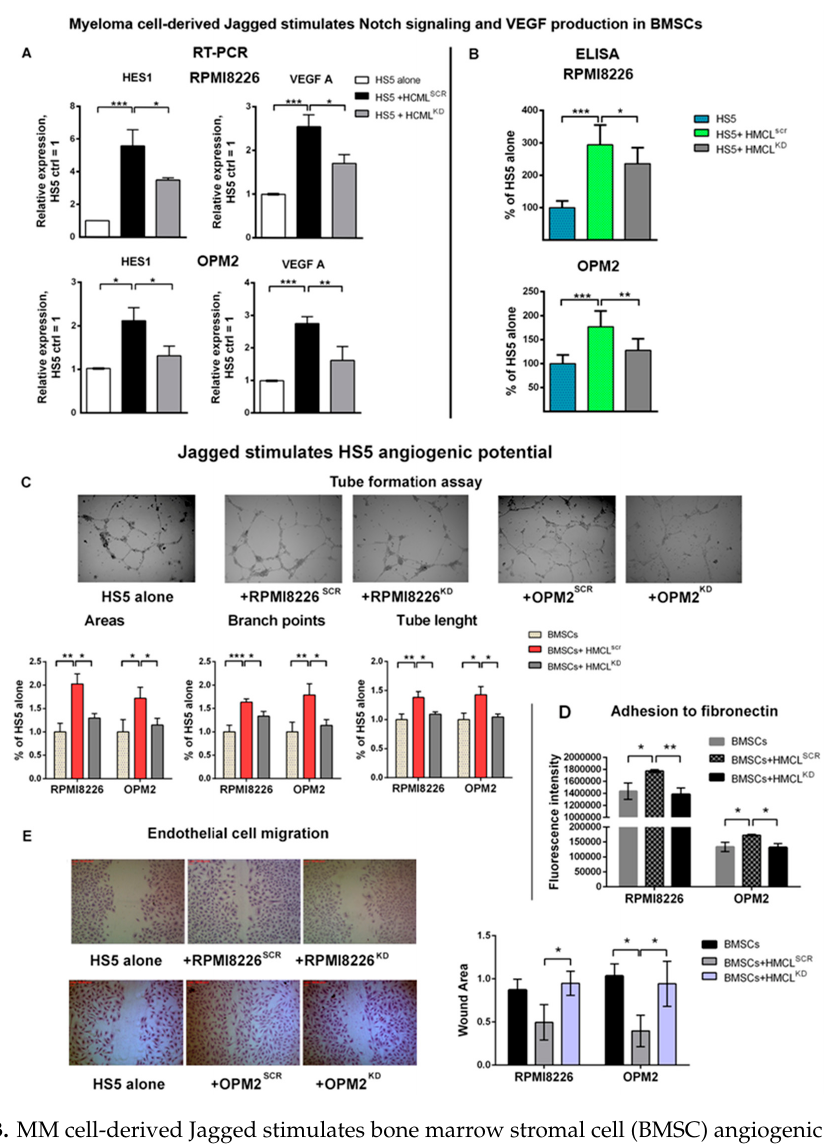
Figure 3. MM cell-derived Jagged stimulates bone marrow stromal cell (BMSC) angiogenic potential: ( A ) Activation of Notch signaling and VEGF-A expression induced in HS5 cells co-cultured with HMCLs SCR or HMCLs KD assessed by qRT-PCR of the relative gene expression variation for the Notch target gene HES1 and VEGF (normalized to HRPT) calculated by the 2 −ΔΔ Ct formula (data are expressed as the mean value ± SD). Statistical analyses were carried out by one-way ANOVA and Tukey post-hoc test; * is for p ≤ 0.05; ** is for p ≤ 0.01; *** is for p ≤ 0.001. ( B ) ELISA for VEGF-A secreted by co-culture systems of HS5 cells and HMCLs SCR or HMCLs KD . Data represent the amount of VEGF released by each culture normalized on VEGF expressed by HMCL cultured alone. In each sample, the amount of VEGF (pg/mL) was normalized to the cell concentration. ( C ) Tube formation assay of the HPAECs stimulated with CM secreted by co-culture systems of the HS5 cells and HMCLs SCR or HMCLs KD . 4X magnification images are shown. Graphs show the quantification of the number of areas, branch points and total tube length. ( D ) Adhesion to fibronectin of the HPAECs stained with Calcein-AM and treated with CM secreted by the co-culture systems of the HS5 cells and HMCLs SCR or HMCLs KD . The graph reports the intensity of the adherent fluorescent cells. ( E ) Migration of the HPAECs treated with CM of co-culture systems of HS5 cells and HMCLs SCR or HMCLs KD was assessed by wound healing assays. Representative pictures at 4X magnification. The graph shows the average open area of the wounds expressed in pixels. Statistical analyses were carried out by ANOVA and Tukey post-hoc tests; * is for p ≤ 0.05; ** is for p ≤ 0.01; *** is for p ≤